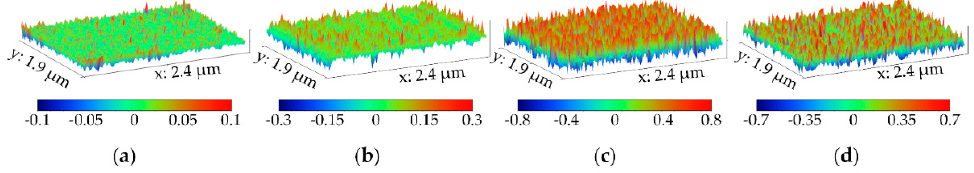
Figure 6. Micro-relief of titanium Grade 2 surface recovered by interferometric method in the initial state ( a ), after nitriding at 750 ◦ C ( b ) and 900 ◦ C ( c ), and after boriding ( d ). According to the obtained results, it was determined that after nitriding at a tempera- ture of 750 ◦ C, the height parameters of the surface roughness increase by ~2.5...2.7 times and the step parameters decrease slightly (Table 3) due to the fact that a new microrelief is formed on the surface after nitriding where nitride phases of Ti 2 N are the new peaks, which are formed at the grain boundaries. By increasing the nitriding temperature to 900 ◦ C, the height parameters increase by 8.5...10.0 times and the step parameters decrease by 2.2...3.3 times (Table 3) due to the formation of the additional peaks of the surface profile because